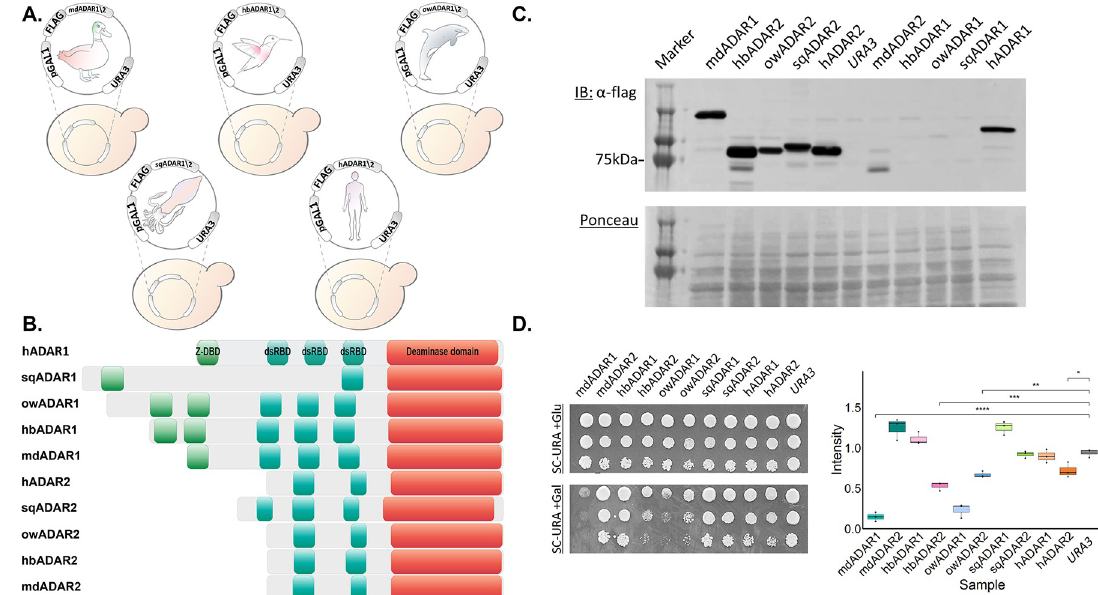
Fig 1. Exogenous expression of heterologous ADARs in yeast differently affects their growth rate (A) Schematic representation of the yeast-based expression system. The coding sequence of heterologous ADAR enzymes N-terminally fused to a FLAG-tag were cloned into a URA3 marked plasmid under a galactose inducible promoter ( GAL1 p). ADARs were originated from Mallard duck ( Anas platyrhynchos ; mdADAR1/2); Hummingbird ( Calypte anna ; hbADAR1/2); Orca whale ( Orcinus orca ; owADAR1/2); Squid ( Loligo opalescens ; sqADAR1/2); and Human ( Homo sapiens ; hADAR1/2). (B) Multiple alignment of the heterologous ADARs used in this study. The ADAR enzymes contain a catalytic deaminase domain (DD, red), two or three double stranded RNA binding domains (dsRBD, blue), and, in ADAR1 only, one or two Z-DNA binding domains (Z-DBD, green). Domains were identified using PROSITE database. All schemes are to scale. (C) Western blot analysis confirms the expression of the ADAR proteins in yeast. Logarithmically growing cells harboring the plasmids described in A were grown in minimal media (SC-URA) supplemented with raffinose (Raf) (SC-URA+Raf) (ADAR expression is off). 2% Galactose (Gal) was then added for 6 hours, to induce the ADAR genes expression. Cell lysates from the SC-URA+Gal media were separated by SDS-PAGE and immunoblotted with anti-FLAG ( α -FLAG) antibody. Cells harboring an empty URA3 marked plasmid were used as a negative control ( URA3 ). Ponceau staining was used as a loading control. (D) The inducible expression of specific heterologous ADAR enzymes impairs cells growth. Left : 10-fold serial dilutions of the indicated strains were spotted on Glucose (top, Glu, ADAR expression is off) and Galactose containing media (bottom, Gal, ADAR expression is on). Plates were incubated at 30˚C for 40h. Cells carrying an empty URA3 plasmid were used as a control. Right : Quantitation of growth impairment. Growth was assessed using a digital image of a drop (second dilution) to generate an estimate of the growth on SD-Gal relative to SD-Glu based on pixel density. Whiskers represent the minimum and maximum values measured from three independent experiments. Stars above the boxplots indicate a statistically significant difference between the means of two samples (ns: p > 0.05; � : p < = 0.05; �� : p < = 0.01; ��� : p < = 0.001; ���� : p < = 0.0001).